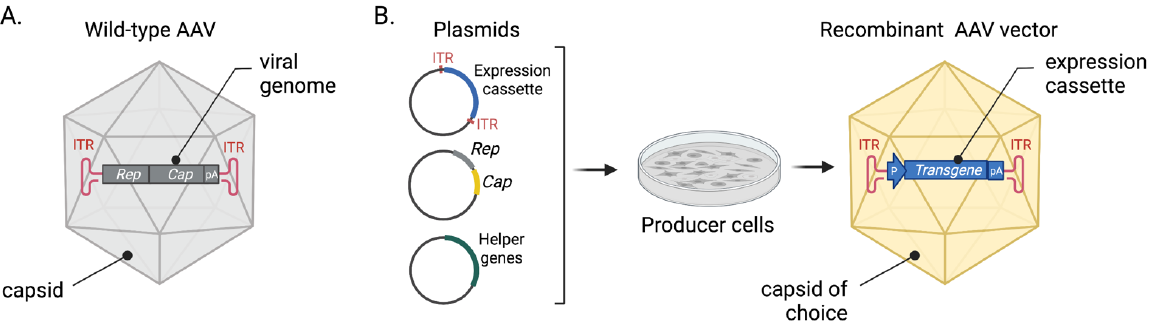
Figure 1. A general principle of creating recombinant AAV vectors. ( A ) Structure of the wild-type AAV. ( B ) System for rAAV production, and basic structure of the recombinant AAV vector.